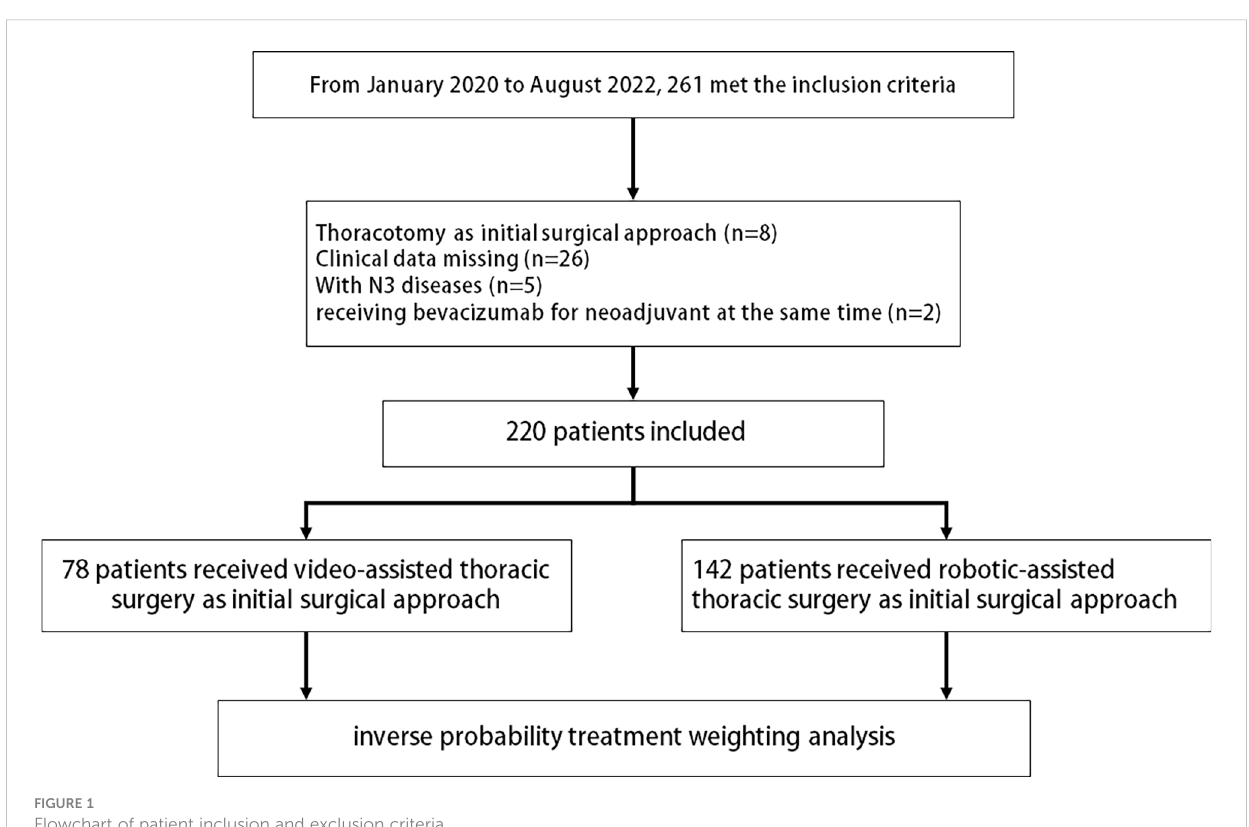
FIGURE 1 Flowchart of patient inclusion and exclusion